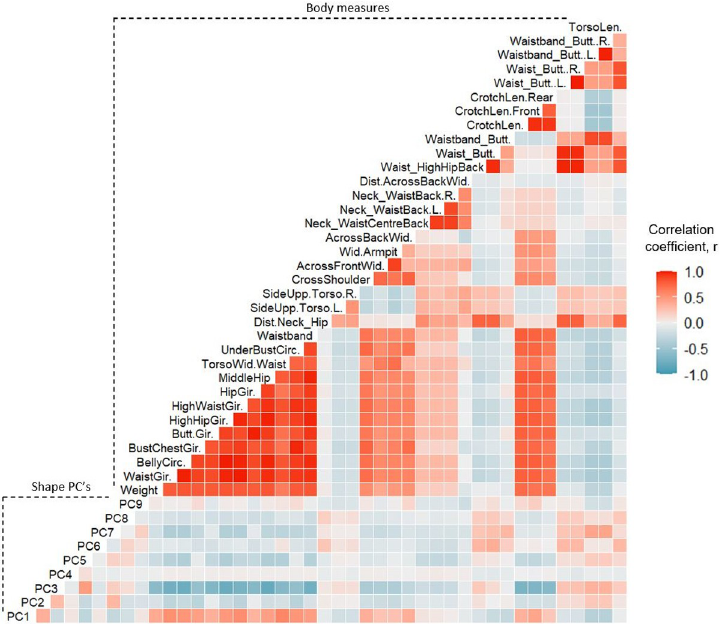
Fig 4. Correlation matrix of male participant measures. Strength of linear relationships between traditional body measures and shape PCs for male participants. Dark red panels indicate a strong positive correlation, dark blue panels indicate a strong negative correlation, lighter panels indicate weak correlation.